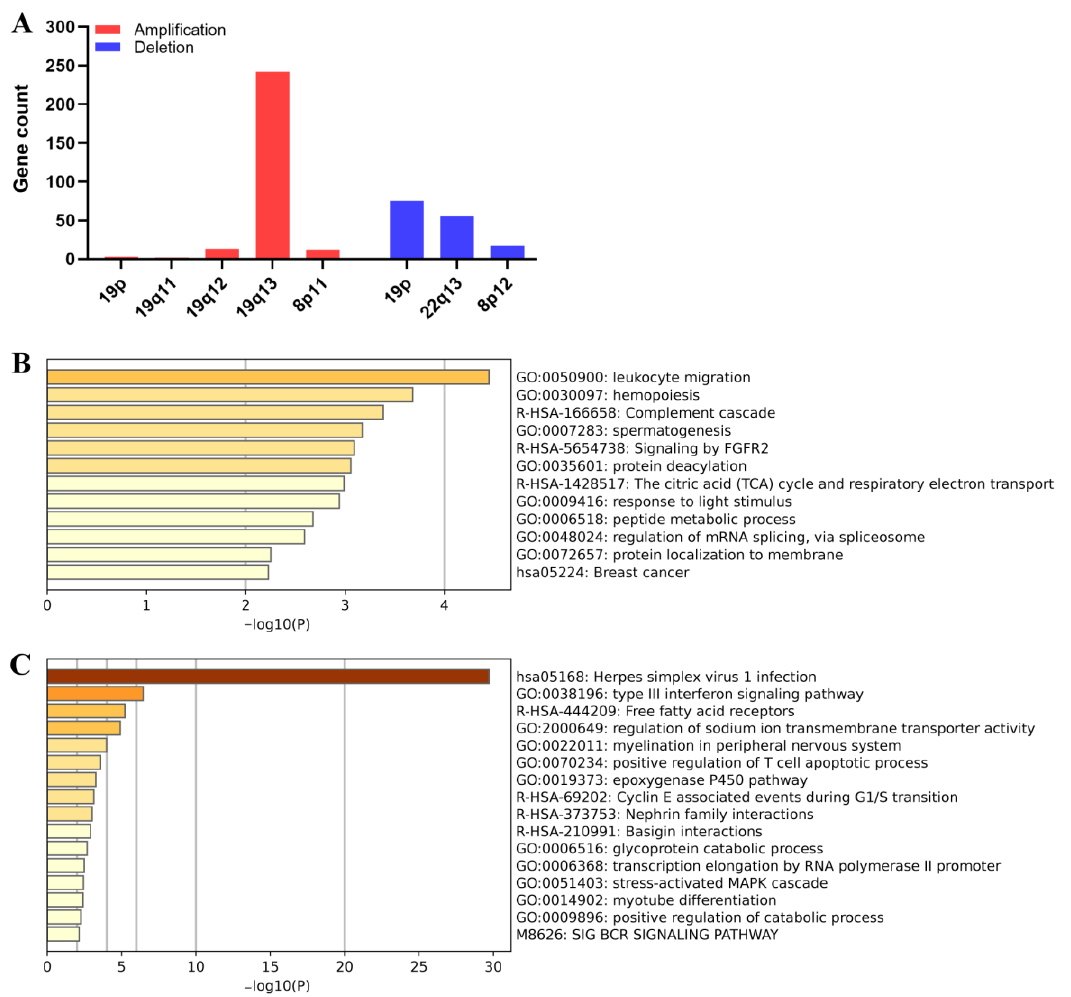
Figure 7. Chromosome location and enrichment analysis of genes with significant CNV in the highly-aneuploid group. ( A ) Chromosome location of genes with CNV enriched in the highly-aneuploid group. ( B ) Enrichment analysis of genes with significant deletions enriched in the highly-aneuploid group. ( C ) Enrichment analysis of genes with significant amplifications enriched in the near-euploid group.